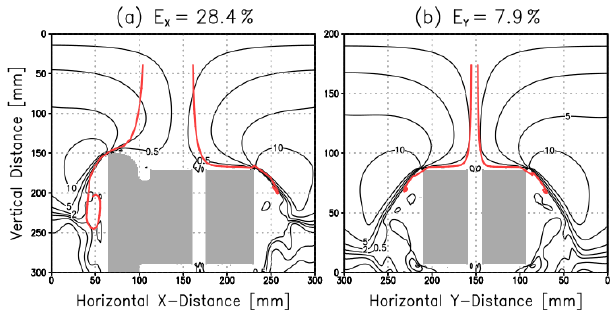
Figure 8. Innermost trajectories against the CPS housing (indicated by red lines) for the (a) horizontal x direction ( u component) and (b) horizontal y direction ( v component). E X and E Y indicate the estimated collection efficiency (%) for each component. Black lines are absolute constants of hyperbolic